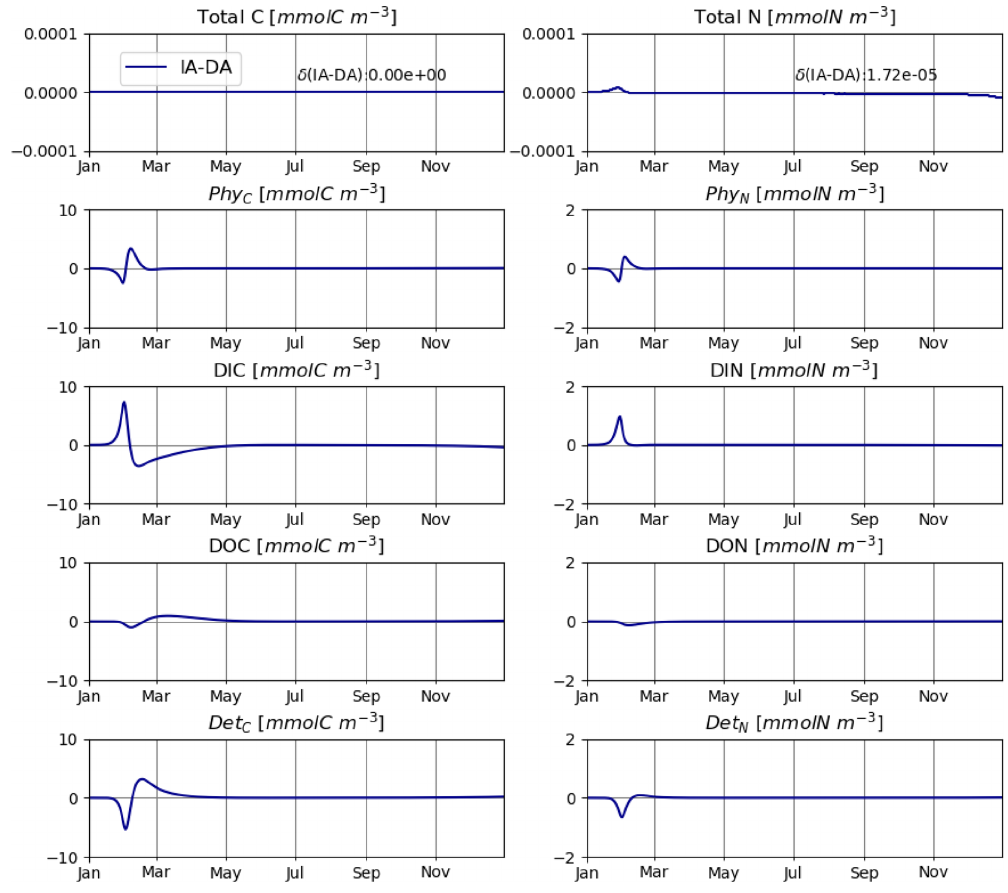
Figure 5. T2: differences between the IA and DA variants for the quantities shown in Fig. 4.